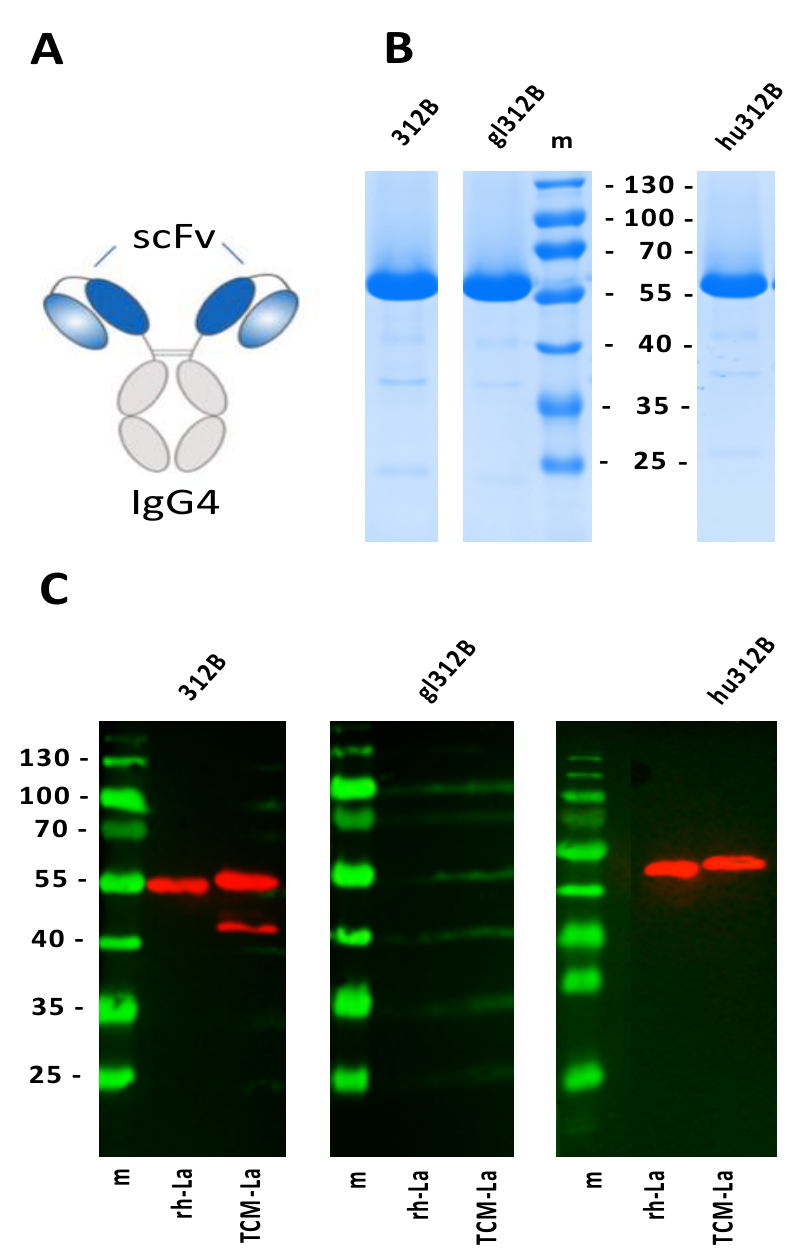
Figure 1. The Complementarity Determining Regions (CDRs) of the anti-La mab 312B confers anti-La reactivity. ( A ) Schematic representation of recombinant 312B ab constructs. Based on the murine (mature), germline, and humanized variable heavy and light chain domains of the anti-La mab 312B, different single-chain fragment variables (scFvs) were constructed and fused to the human IgG4-Fc domain to obtain recombinant murine (mature), germline, or humanized 312B ab constructs. ( B ) Recombinant 312B constructs were isolated by protein A affinity chromatography from cell culture supernatant of permanent 3T3 production cell lines. Purified proteins (312B: mature ab; gl312B: all SHMs were mutated back to the germline sequence; hu312B: CDRs of the murine 312B ab were grafted to the best fitting human framework regions) were separated by SDS-PAGE and subsequently stained with Coomassie-Brilliant Blue. ( C ) The purified 312B ab constructs were tested by SDS-PAGE/immunoblotting against human recombinant La protein (rh-La) and a mutant La version in which the three cysteine residues were mutated to alanine (TCM-La), which makes La protein insensitive to oxidation. m, protein ladder